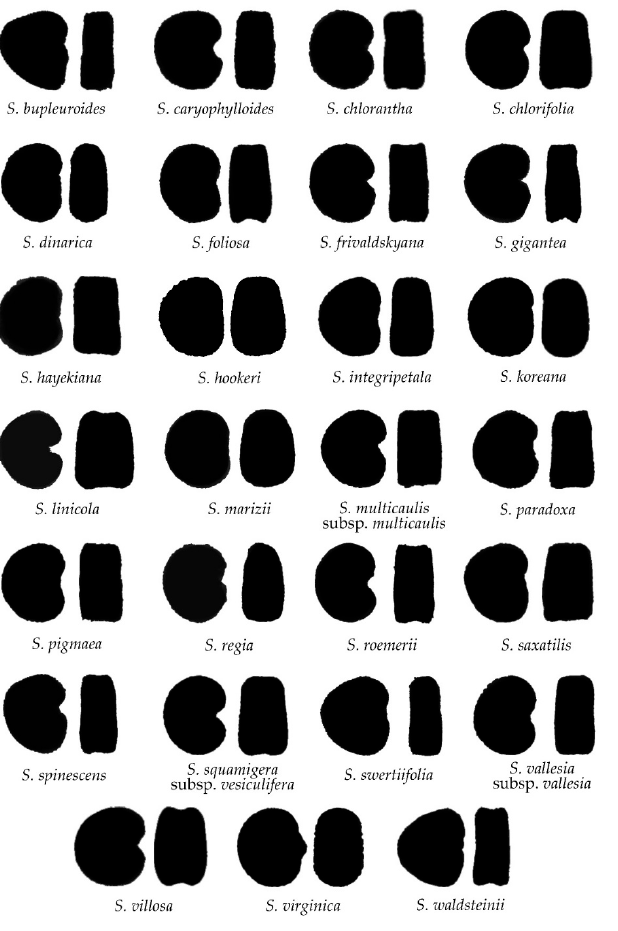
Figure A3. Average silhouettes for the lateral and dorsal views of species in the rugose group. Plants 2022 , 11 , x FOR PEER REVIEW